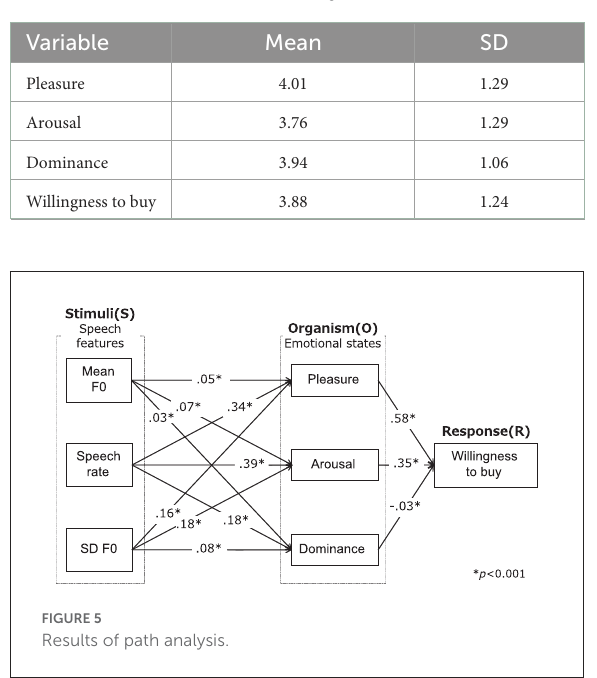
FIGURE5 Results of path analysis.